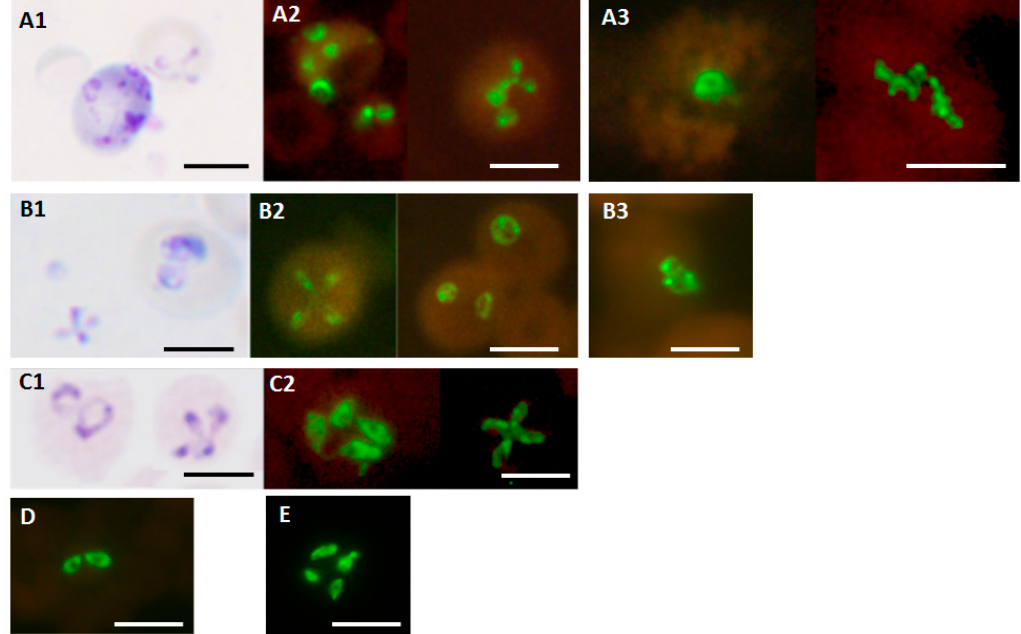
Figure 1. Photographs showing the results of the Babesia genus-specific FISH test on different Babesia species. A— B. microti ; B— B. duncani ; C— B. divergens ; D— B. bovis ; E— B. bigemina with parasite sources